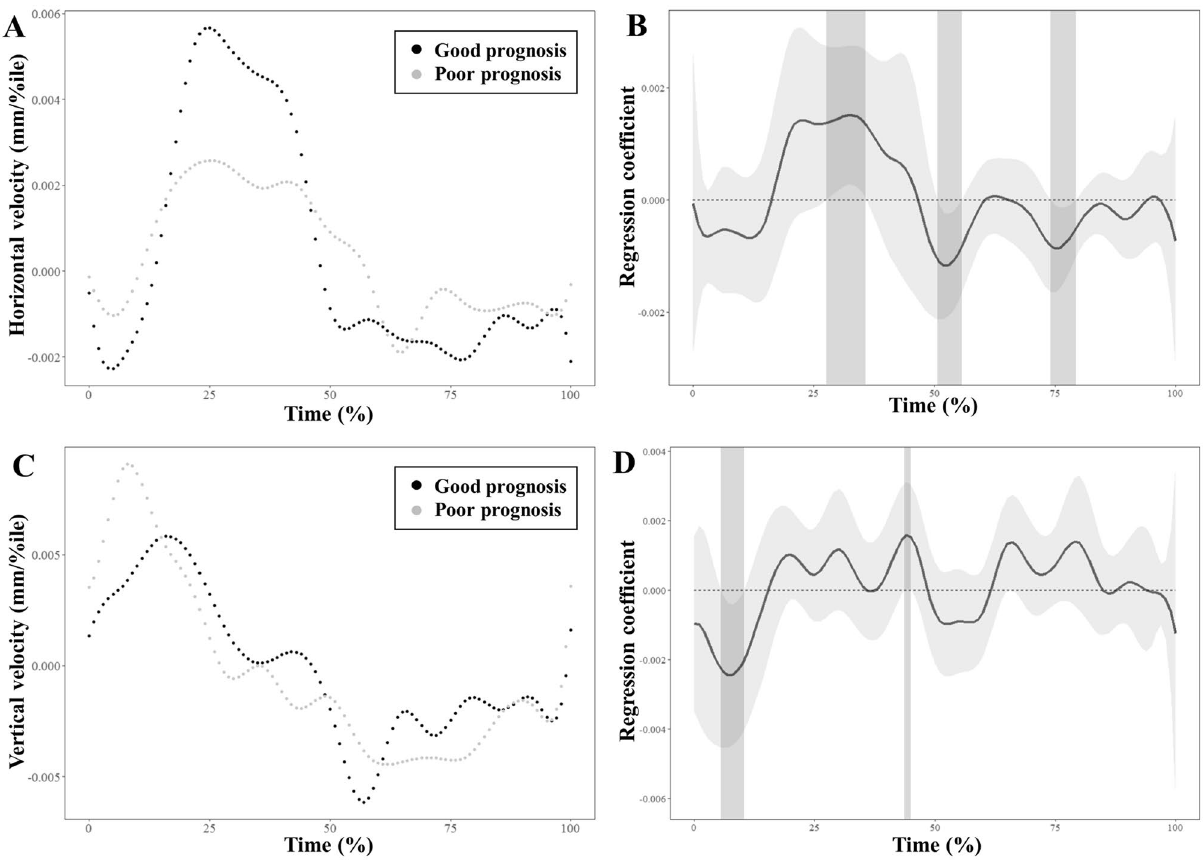
Figure 5. Results of functional regression analysis for horizontal and vertical hyoid velocities. Mean trajectories are illustrated for the horizontal ( A ) and vertical ( C ) hyoid velocities in age- and sex-matched stroke patients with good and poor prognosis. Estimated regression coefficient functions with 95% confidence intervals are shown for the horizontal ( B ) and vertical ( D ) velocities between stroke patients with good and poor prognosis. The light gray zones denote the time interval where the mean difference is significant between the groups.